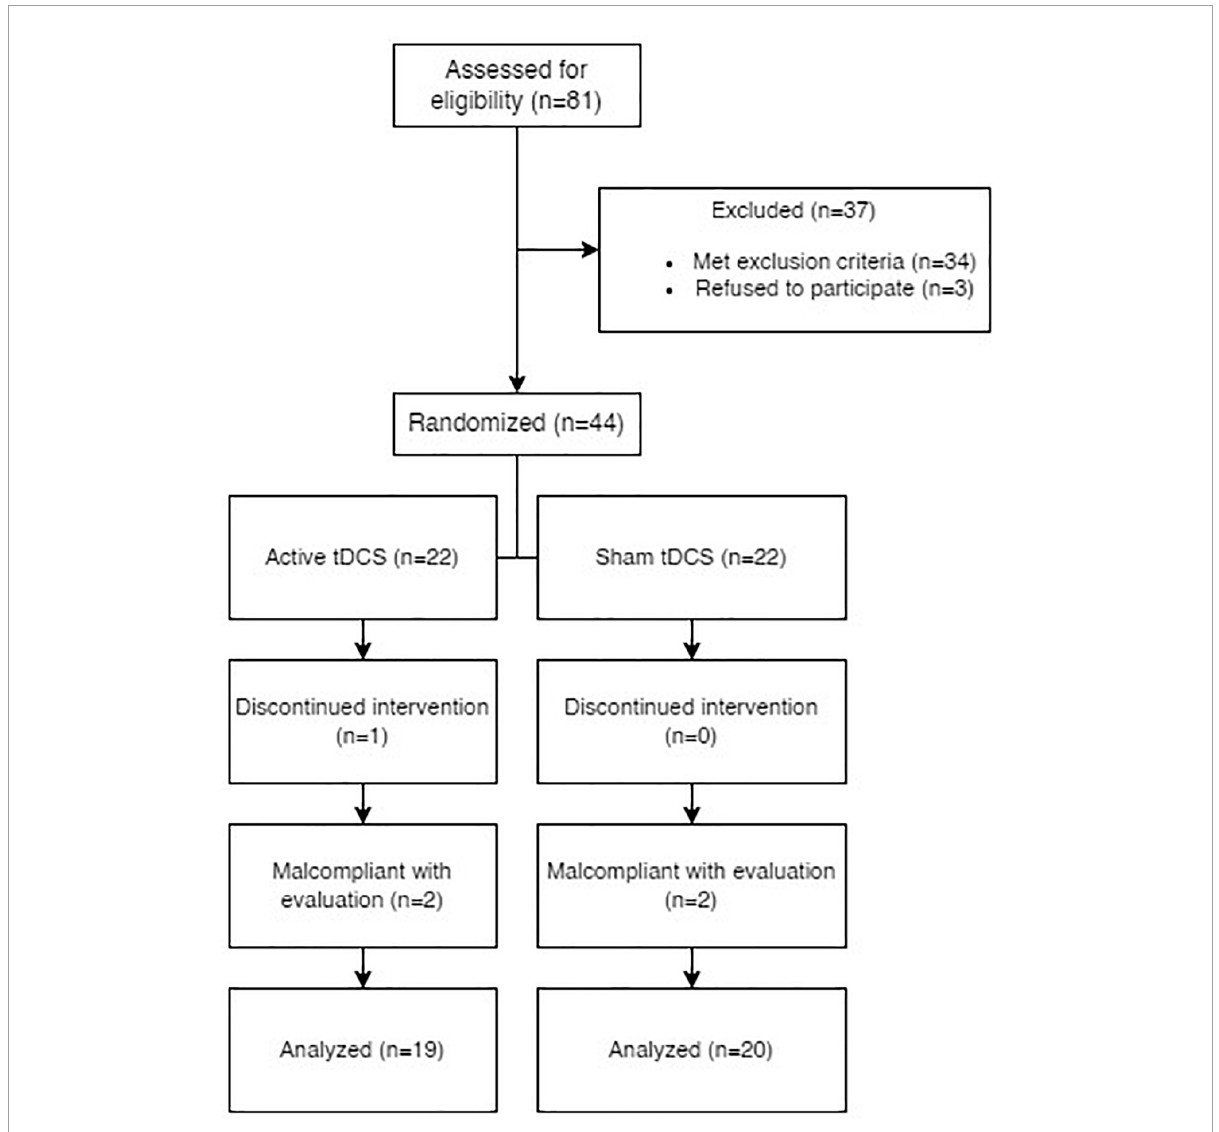
FIGURE1 PRISMA diagram of the enrollment process and further compliance with follow-ups.